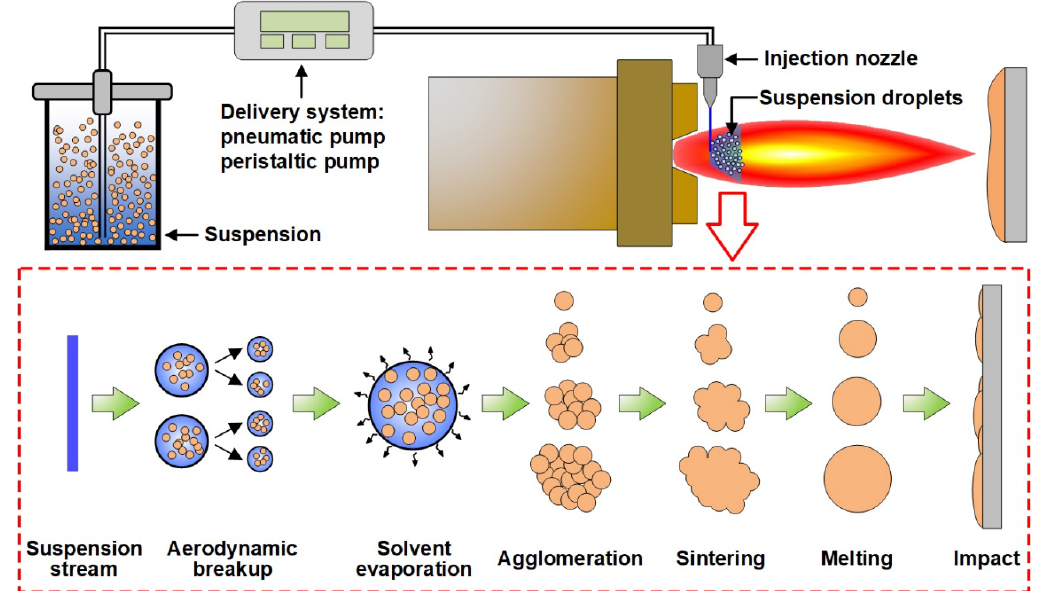
Fig. 66 Schematics of the SPS process and the interactions between suspension and